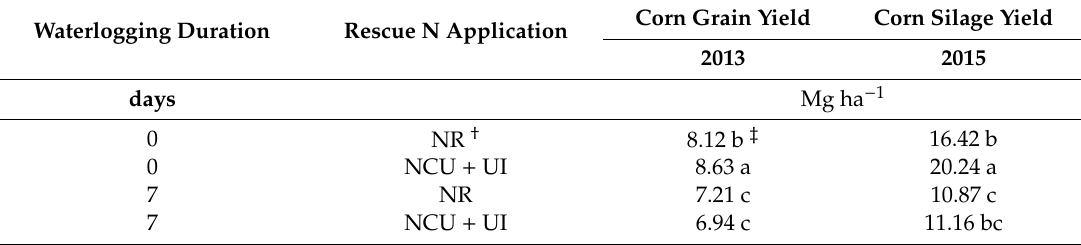
Table 2. E ff ects of waterlogging duration and rescue N application on corn grain yield in 2013 and silage yield in